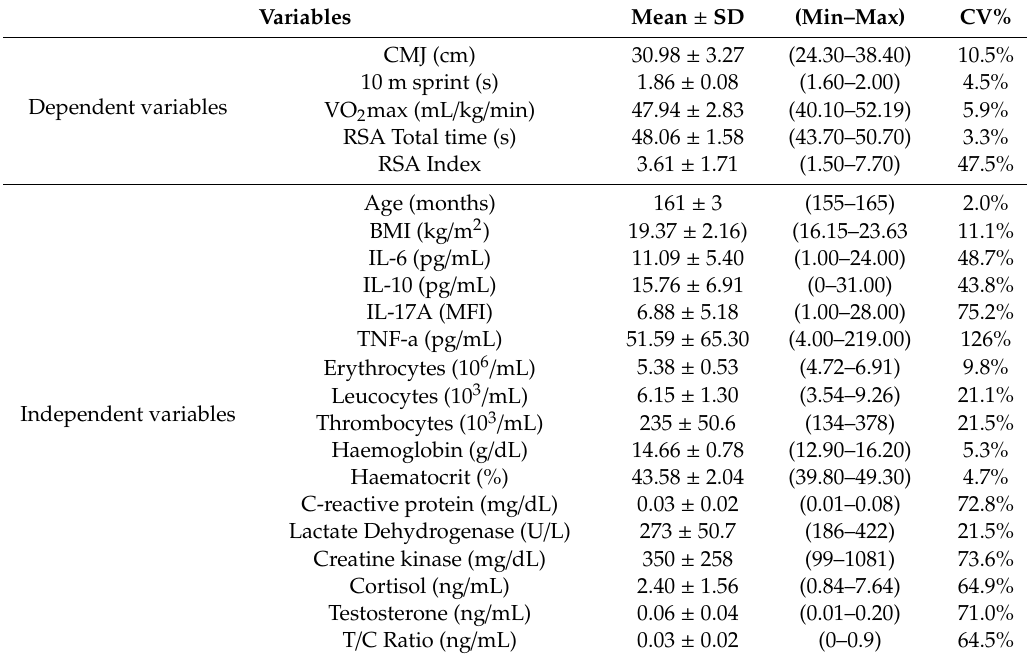
Table 1. Means and range (Min–Max) and CV% of all variables analysed.